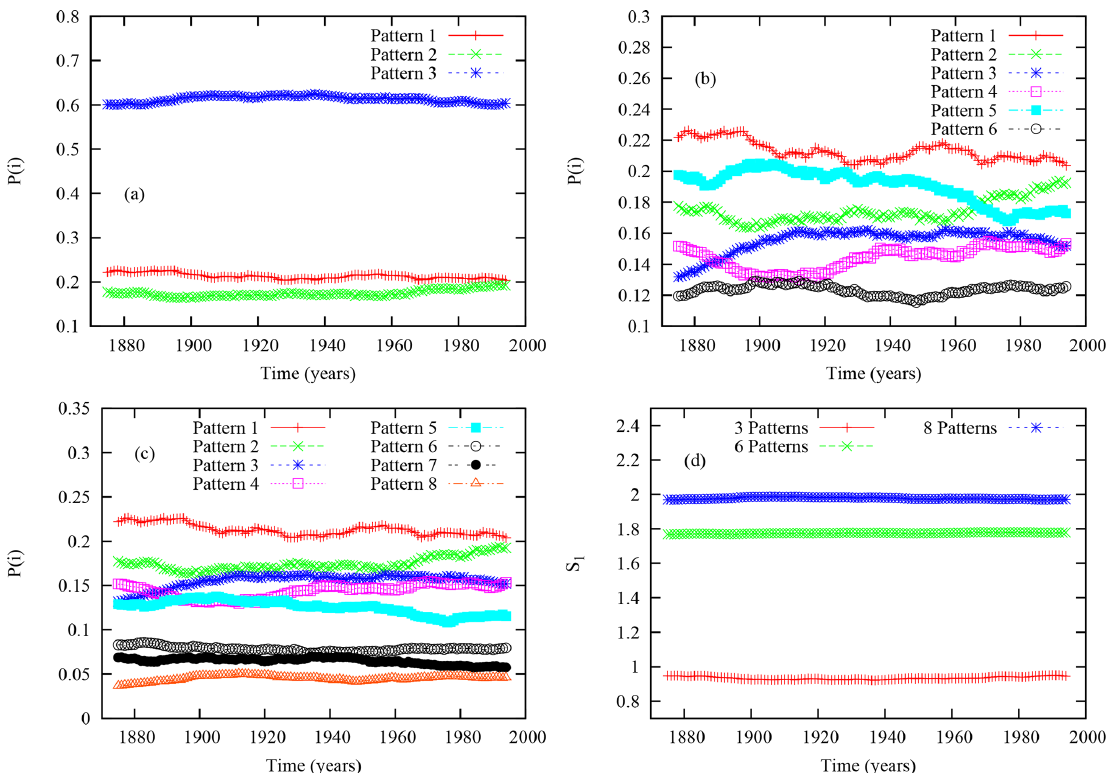
Figure 1. Temporal evolution of (a) the probability of being in one of the three patterns, (b) the probability of being in one of the six patterns, (c) the probability of being in one of the eight patterns, and (d) the Shannon entropy for the three